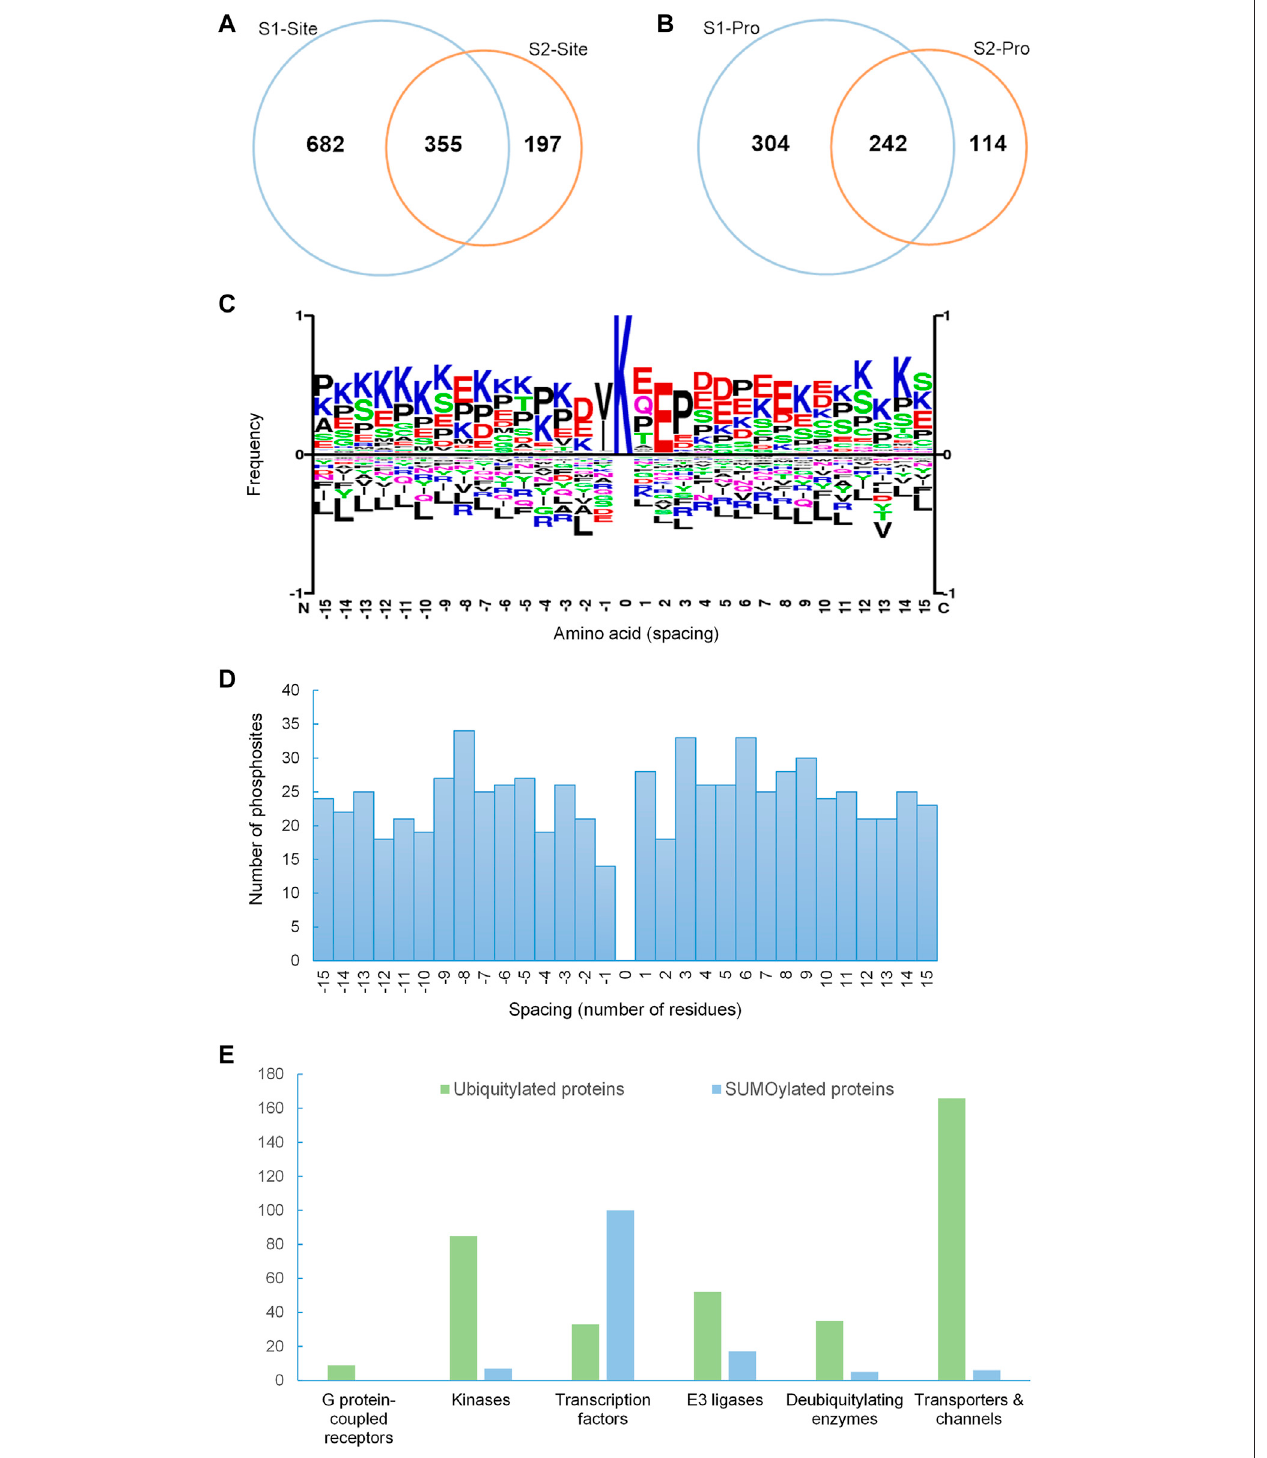
FIGURE 2 | SUMOylation proteome of mpkDCT cells. (A) Venn diagram of SUMO1 and SUMO2 sites and (B) SUMO1 and SUMO2 proteins from mpkDCT cells. (C) Motif analysis revealed a classic KxE consensus motif for the acceptor lysine site and the reversed KxD/E motif. (D) Distribution overview of SUMO-phosphorylation occurrences. SUMOylated sites were from this study, and phosphorylation sites were retrieved from PhosphoSitePlus. SUMOylated lysines are at position 0, with spacing indicating the relative position of phosphorylation. (E) Comparison of different protein classes between ubiquitylated proteins from mouse kidney and the SUMOylation proteome of mpkDCT cells highlights the high degree of involvement of SUMOylation in gene transcription.